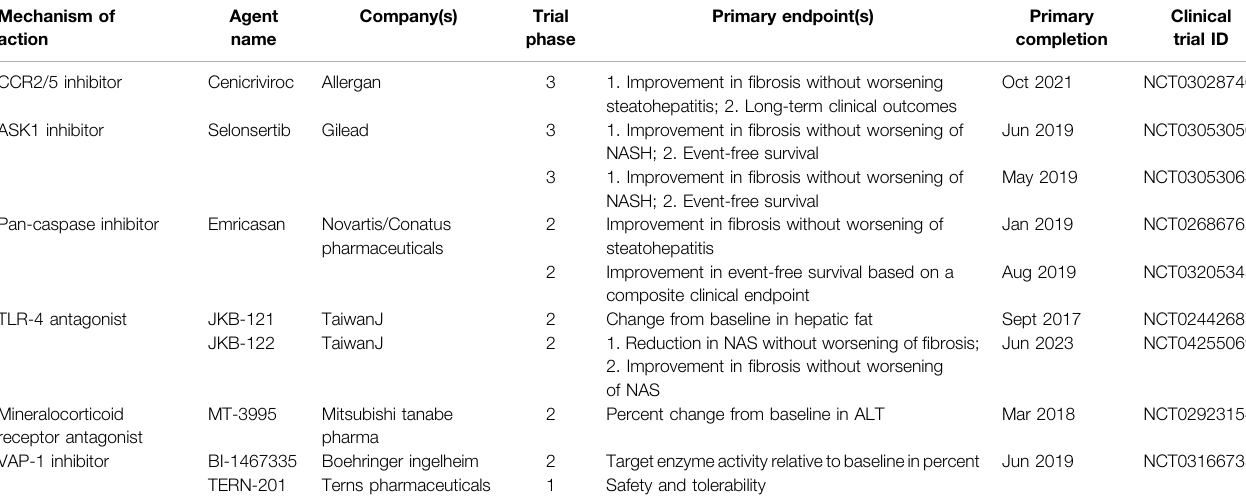
TABLE 2 | In fl ammation-targeted pharmacologic agents that have completed or are undergoing clinical trials for NASH. Mechanism of